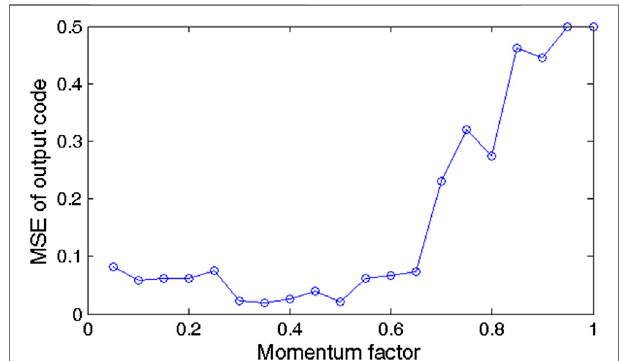
FIGURE 15 | Defect evaluation results of different regularization